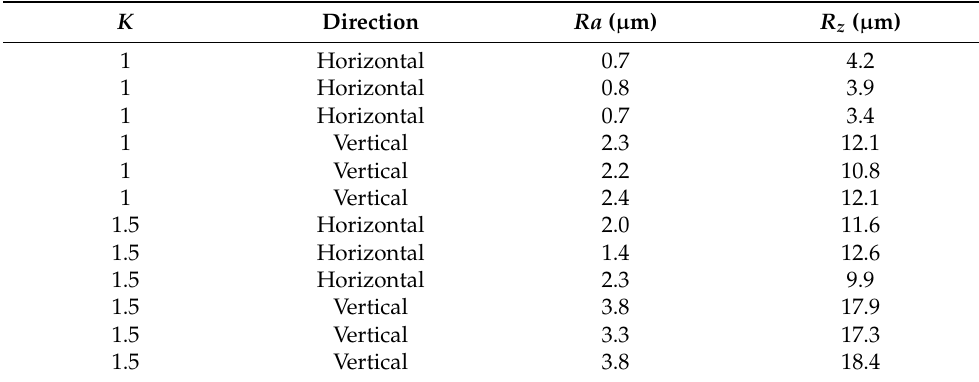
Figure 6. Surface morphology of LJWF-DMD-printed specimens, ( a ) front view, ( b ) back view, ( c ) 2D optical microscopy stair-step effect image (1) ( d ) and enlarged 2D optical microscopy stair-step effect image (2). Table 4. Surface roughness of LJWF-DMD AM thin-walled parts, mechanically measured.